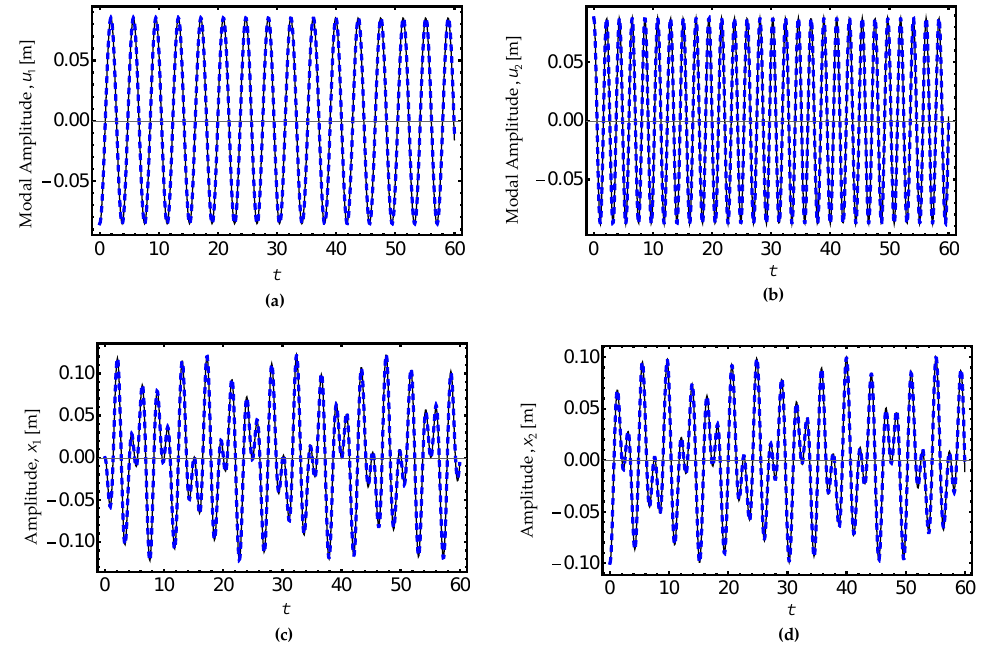
Figure 7. Amplitude versus time response curves: ( a ) u 1 vs t , ( b ) u 2 vs t , ( c ) x 1 vs t , ( d ) x 2 vs t . Almost periodic solutions can be observed when the modal displacements are transformed back into the original coordinate systems x 1 and x 2 using the relationships (37). Here the solid line represents the numerical integration solution of Equation (36), while the dashed, colored line describes the approximate solution obtained from Equation (42).